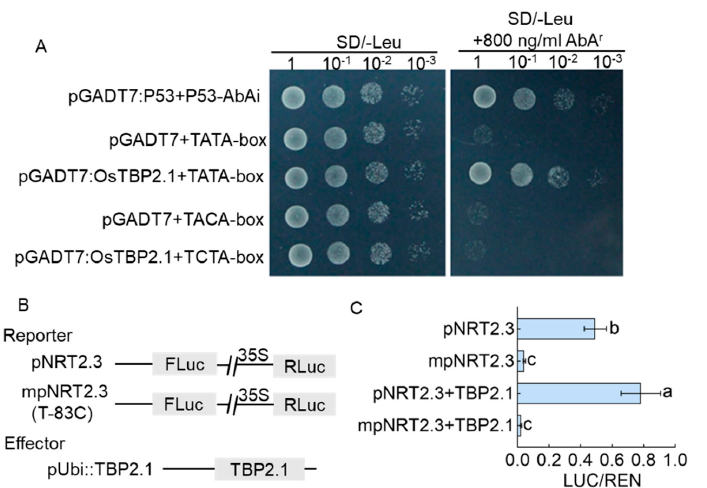
Figure 5. OsTBP2.1 binds to the cis-acting element of OsNRT2.3 ( A ) OsTBP2.1 binding to the